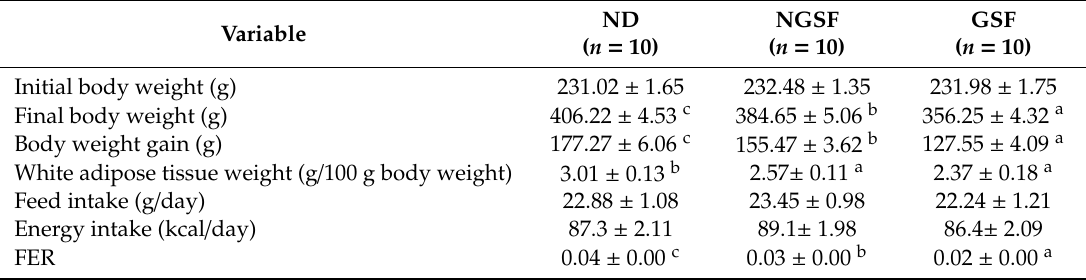
Table 3. Body weight gain and adipose tissue weight in ovariectomized rats fed with germinated Superjami rice flour.